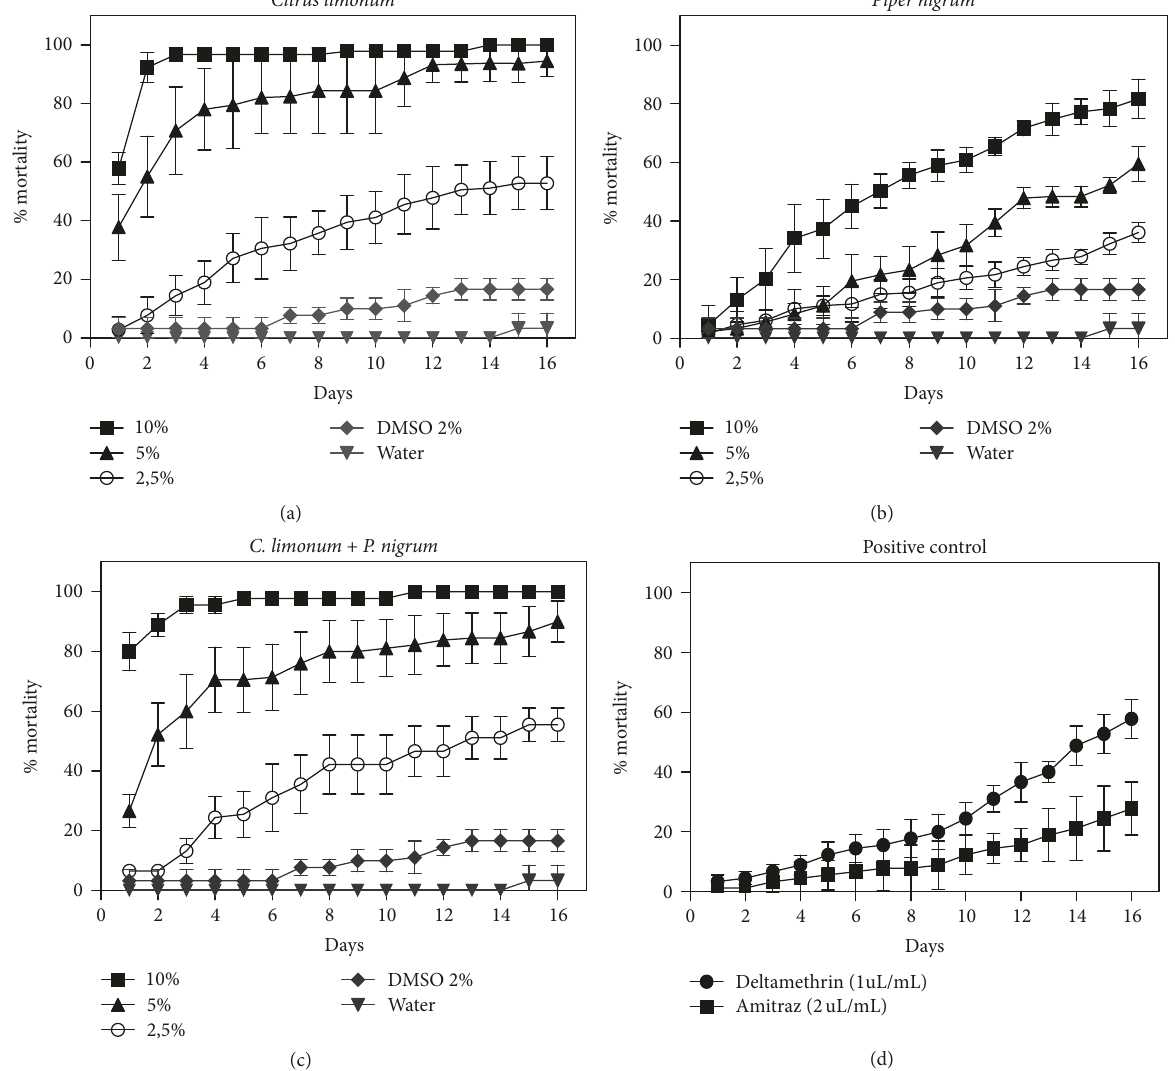
Figure 1: Mortality percentage of R. microplus engorged females exposed to Citrus limonum and Piper nigrum essential oil. Adult Immersion Test (AIT) on mortality of the tick R. microplus . Groups treated with different concentrations of essential oil of C. limonum (a), P. nigrum (b), the combination of both oils (c), and positive control were the commercial acaricides Deltamethrin and Amitraz. In combination oils used the 1 :1 (vol/vol) concentration of each oil. Results are means ± SD of five